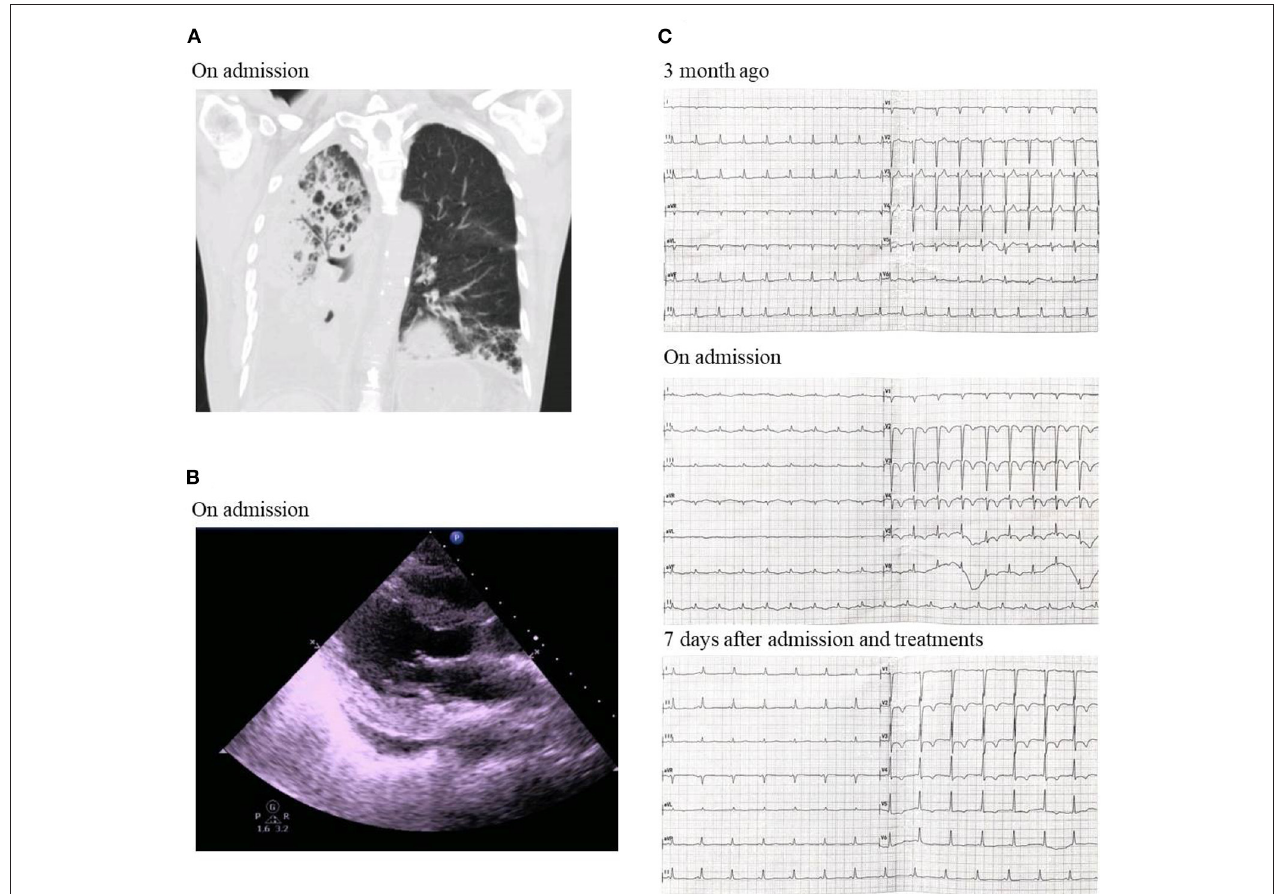
FIGURE 1 | (A) Chest CT on admission. (B) Echocardiography showing ventricle size within normal range, increased atrium size and markedly decrease cardiac ejection fraction on admission. (C) Electrocardiogram showing sinus tachycardia, low voltage of limb leads, T wave inversion in anterior waves and V1–V3 QS type